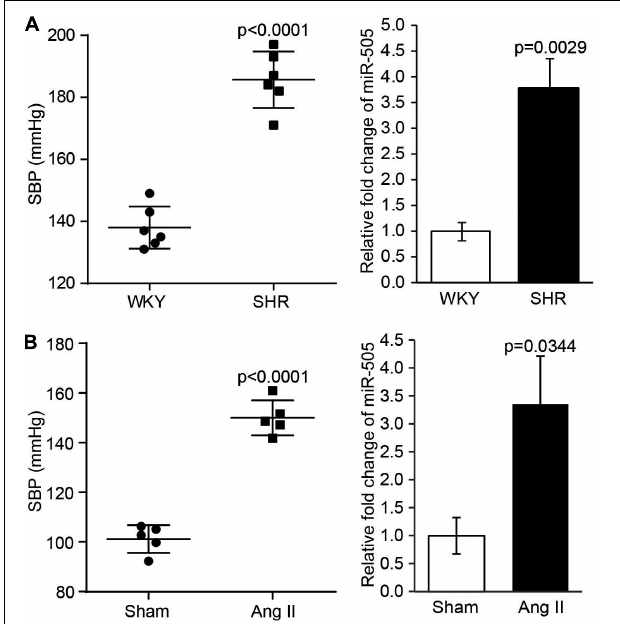
FIGURE 1 | The level of plasma miR-505 is elevated in hypertensive animal models. (A) SBP was measured from 8-week-old SHRs and WKY rats ( n = 6 per group). In addition, the level of plasma miR-505 from SHRs and WKY rats was analyzed by real-time PCR. Relative fold change of miR-505 was plotted against that from WKY controls. Data represent mean ± SEM. P values are derived from the Student’s t -test. (B) Eight-week-old C57BL/6J mice were subject to Ang II infusion at 1,000 ng/min/kg via osmotic mini-pumps for 2 weeks. Sham controls (Sham) received saline infusion in the same manner. SBP was measured at the end of the 2-week infusion ( n = 5 per group). The plasma level of miR-505 from the Ang II-infused mice and sham controls was analyzed by real-time PCR. Relative fold change of miR-505 was plotted against that from the sham controls. Data represent mean ± SEM. P values are derived from the Student’s t